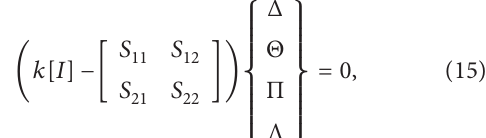
Substituting equation (14) into equation (15) gives a set of 12 homogeneous linear simultaneous equations: